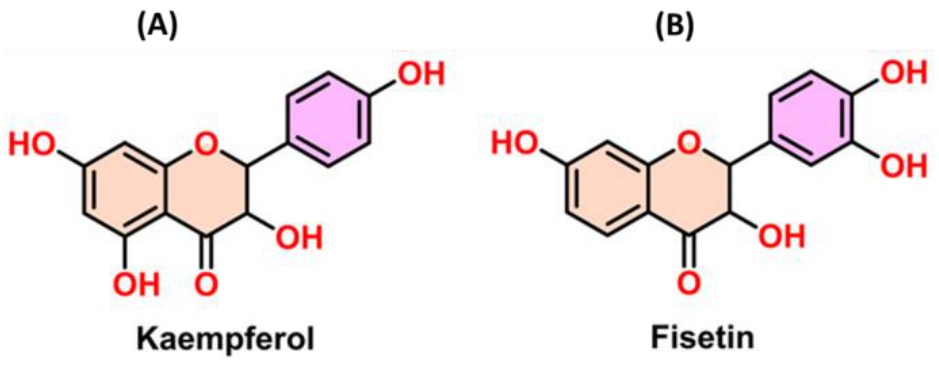
Figure 1. Molecular structure of ( A ) kaempferol and ( B ) fisetin. Fisetin is another flavonoid of the same group involved in a series of cellular events, including cell apoptosis [36], which affects various signaling pathways [37]. Additionally, fisetin regulates the cell cycle and inhibits cyclin-dependent kinases (CDKs) in cancer cell lines [26]. Studies show that fisetin inhibits the proliferation of a series of breast cancer cells (4T1, MCF-7, and MDA-MB-231) in a dose- and time-dependent manner [38]. The cytotoxic potential of fisetin in MDA-MB-231 and MDA-MB-468 cells showed a significant decrease in the percentage of cells in the G1 phase of the cell cycle and a considerable increase in the percentage of cells in the G2/M